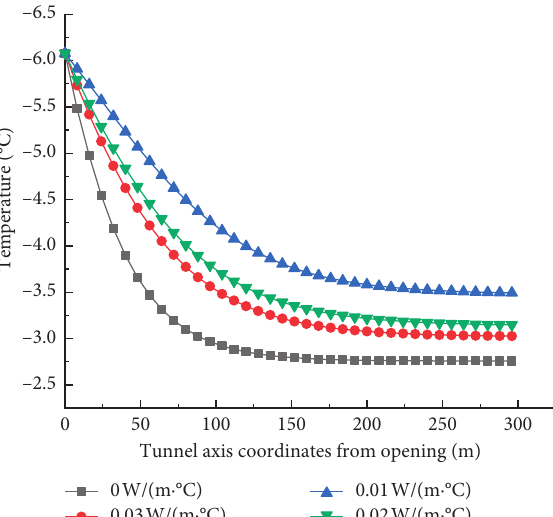
Figure 19: Distribution characteristics of the annual average air temperature inside the lining in the tunnel axis under different thermal conductivities.